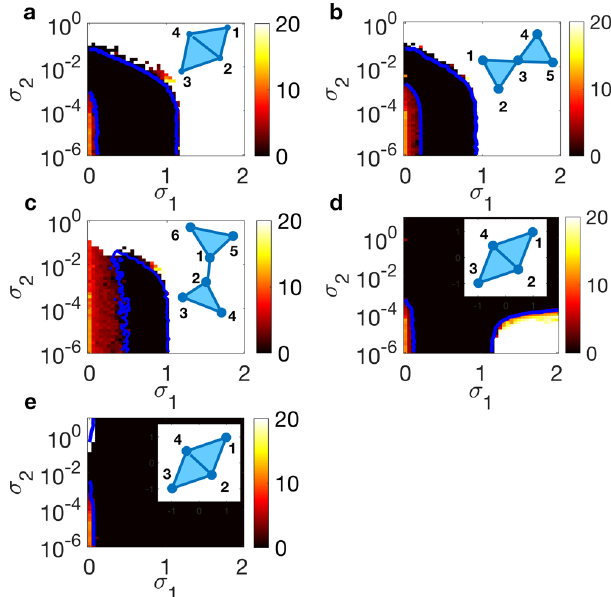
Fig. 1 Synchronization in simplicial complexes of Rössler oscillators. Contour plots of the time averaged (over an observation time T = 500) synchronization error E (see “ Methods ” for de fi nition and the vertical bars of each panel for the color code) in the plane ( σ 1 , σ 2 ) for some examples of simplicial complexes (whose sketches are reported in the top left of each panel). Simulations refer to coupled Rössler oscillators ( x = ( x , y , z ) T and